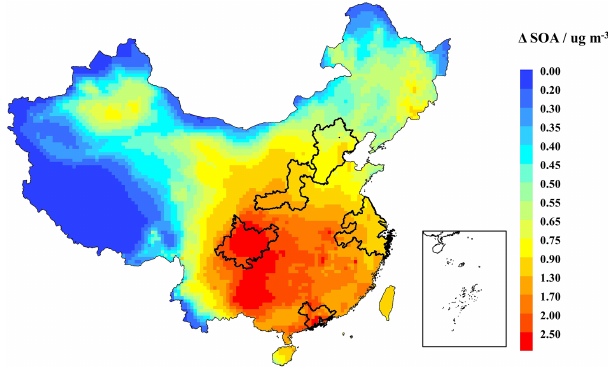
Figure 4. Spatial variations in impact of BVOC emission on SOA